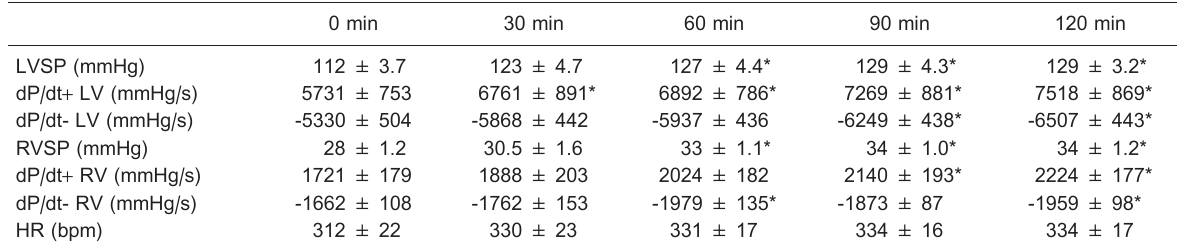
Table 1. Effects of lead on the time course changes of hemodynamic parameters of anesthetized rats. 0